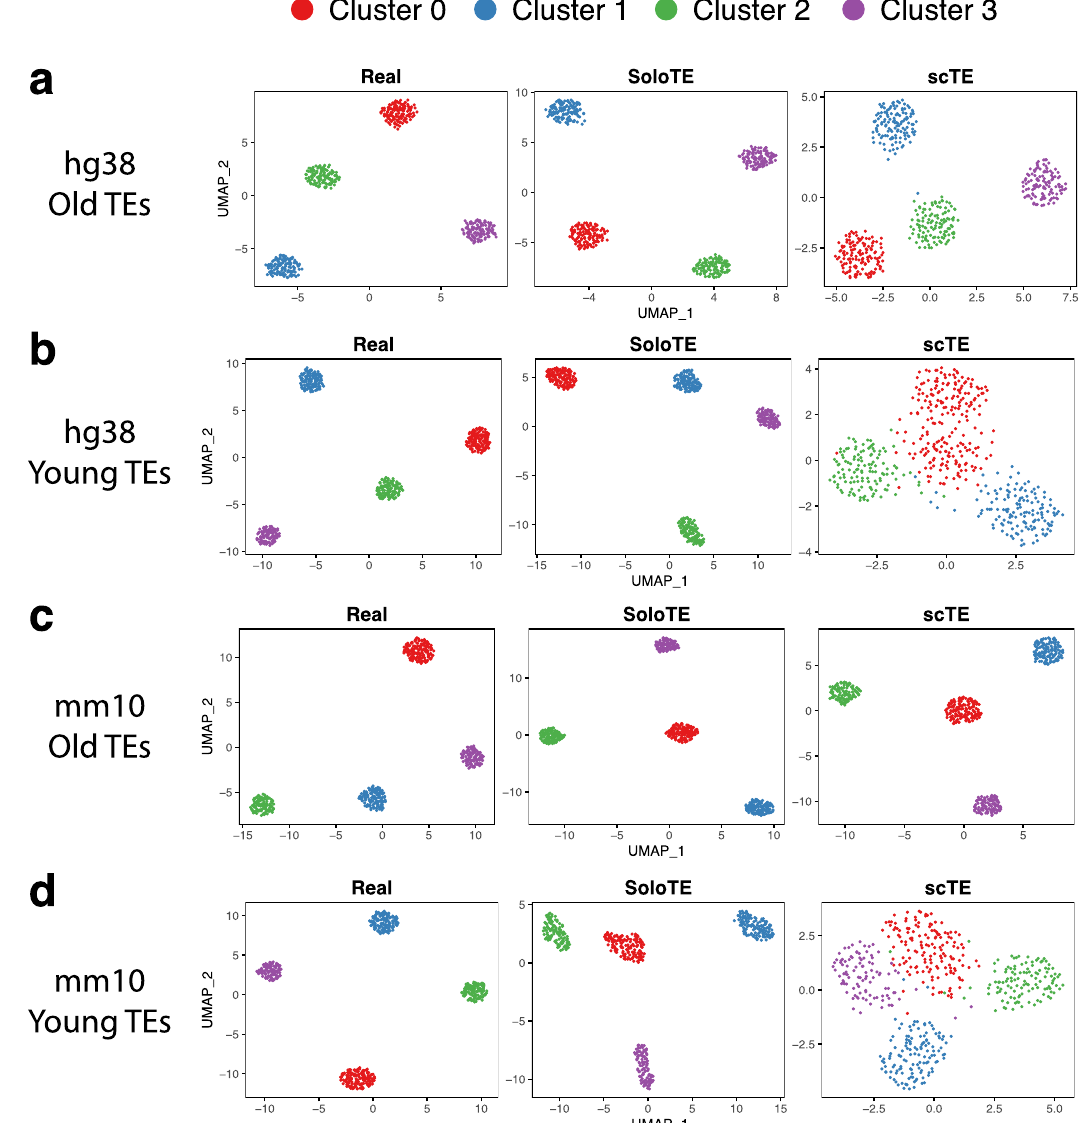
Fig. 2 UMAP dimensional reduction plots for each of the simulated datasets. a hg38 Old TEs. b hg38 Young TEs. c mm10 Old TEs. d mm10 Young TEs. Above each UMAP plot, the dataset from which it was generated, is indicated: ground truth expression matrix ( “ Real ” ), SoloTE expression matrix ( “ SoloTE ” ), and scTE expression matrix ( “ scTE ” ). Clusters are colored red (Cluster 0), blue (Cluster 1), green (Cluster 2), purple (Cluster